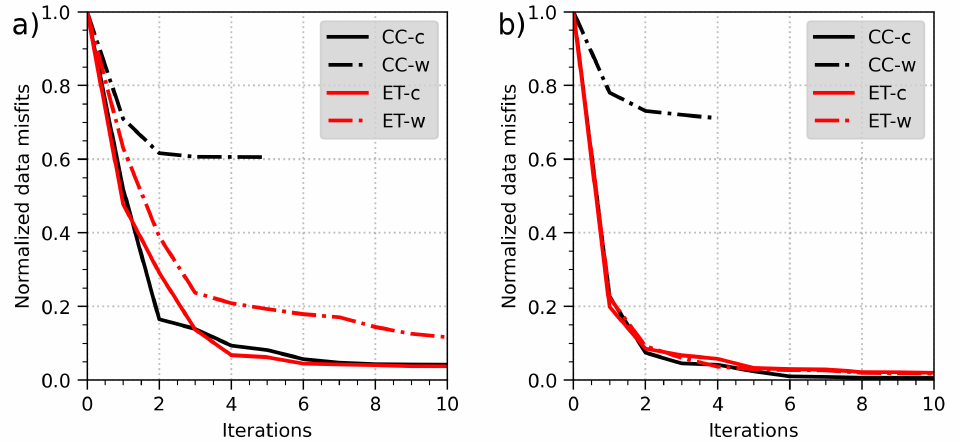
Figure 8. ( a ) Reductions of the normalized travel-time data misfits for V P inversion; ( b ) reductions of the normalized travel-time data misfits for V S inversion. The solid-black and dash-dotted-black lines indicate the traditional CC travel-time data misfits with correct and wrong source wavelets. The solid-red and dash-dotted-red lines indicate the new ET travel-time data misfits with correct and wrong source wavelets.